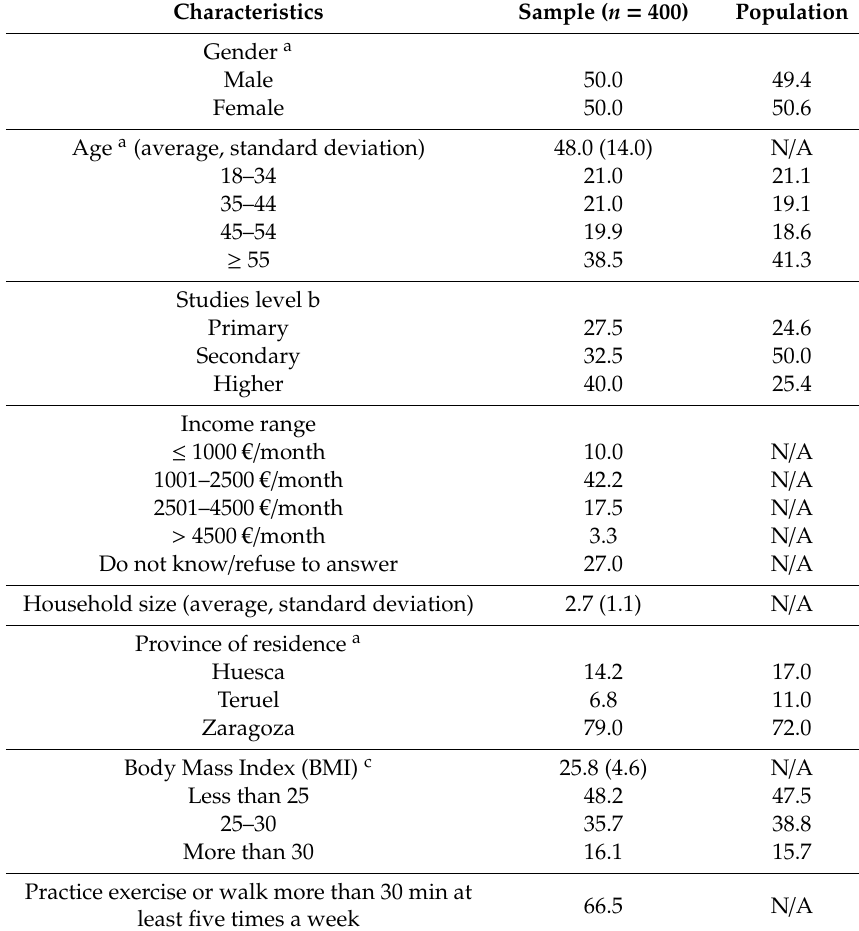
Table 1. Sample demographic characteristics (%, unless